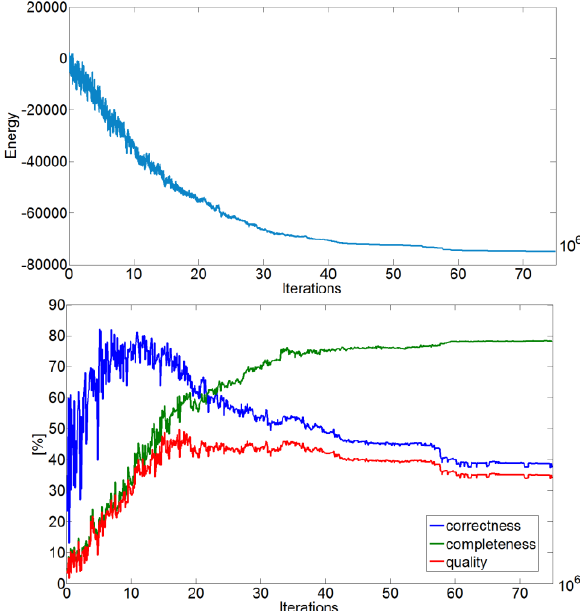
Figure 8. The modelled energy converges for increasing iterations (top). The completeness and quality rate increase while the correctness rate is decreasing (bottom).